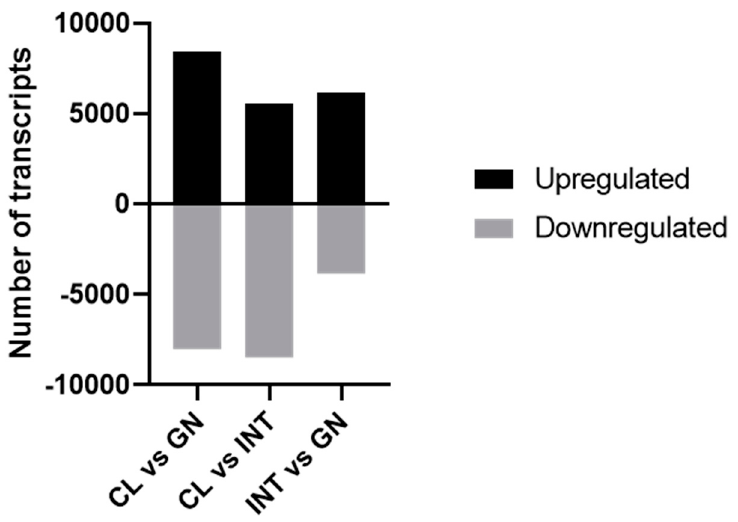
Figure 6. Paired comparisons of differentially expressed transcripts between tissues of L. albus . Upregulated and downregulated transcripts measured are indicated by black and gray columns, respectively. Parameters: fold change (absolute values > 4.0) and FDR corrected p value ( p < 0.001). Abbreviations: CL: coelomocyte, INT: intestine, GN: gonad.